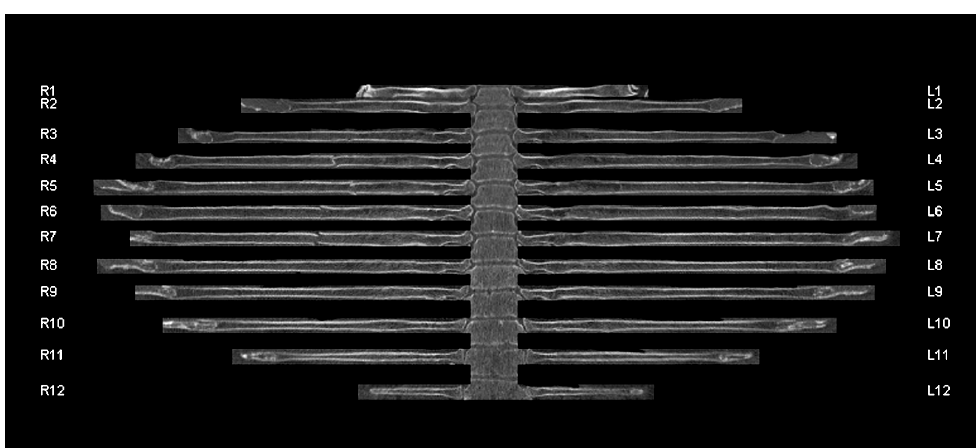
Figure 4. Unfolded rib view of a 64-year-old patient with a serial rib fracture of the 4th to 7th rib on the right side. R1-12 refers to the 1st to 12th rib of the right hemithorax. L1-12 refers to the 1st to 12th rib of the left hemithorax.